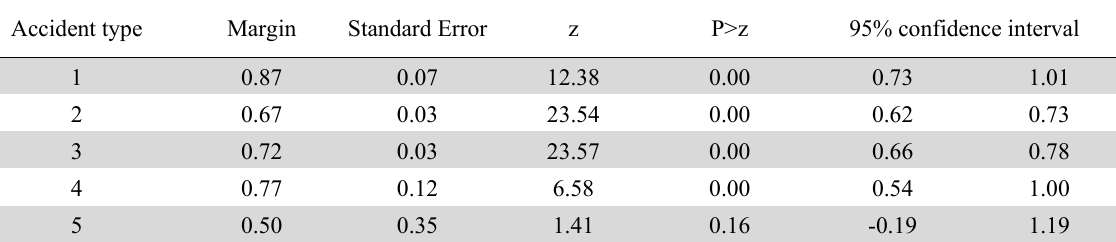
Quantile 1 injured people by accident type Accident